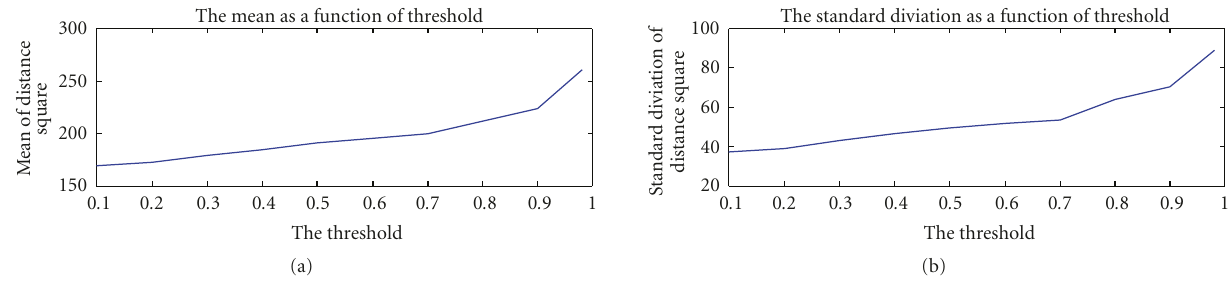
Figure 23: The mean and the standard deviation of graph inertia as a function of the threshold. Observe that both of them increase as the curvature becomes more and more negative.